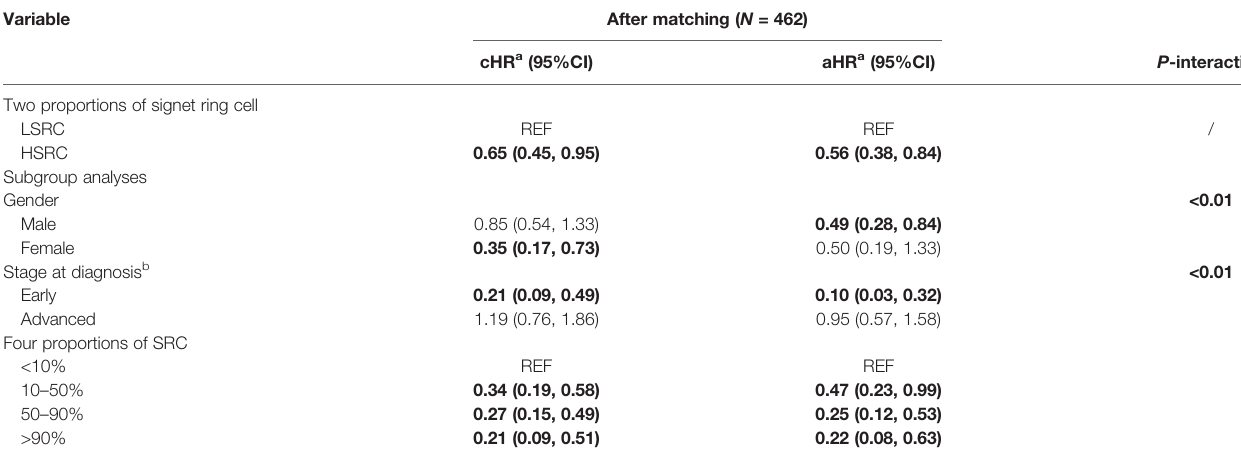
TABLE 2 | Risk of mortality according to the clinical pathology among GC patients from Cox regression analysis. Variable